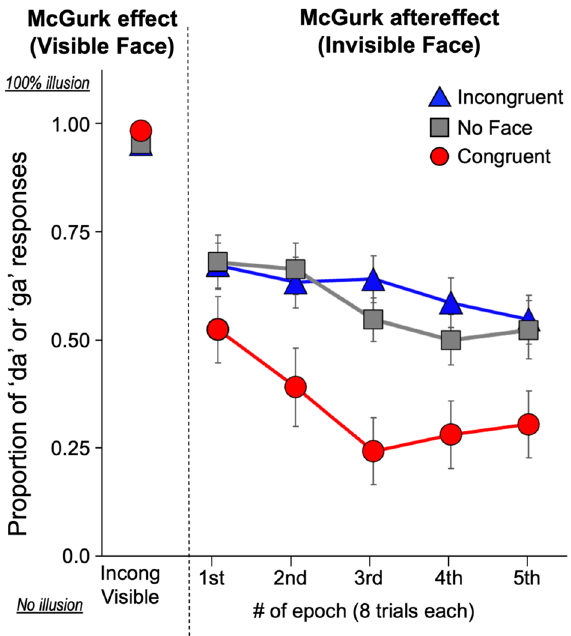
Figure 3. Mean proportion of ‘da’ or ‘ga’ response (illusory percepts) as a function of epoch (8 trials of different speakers). The leftmost plots are for the baseline, Incongruent Visible condition. Error bars denotes the standard error of the